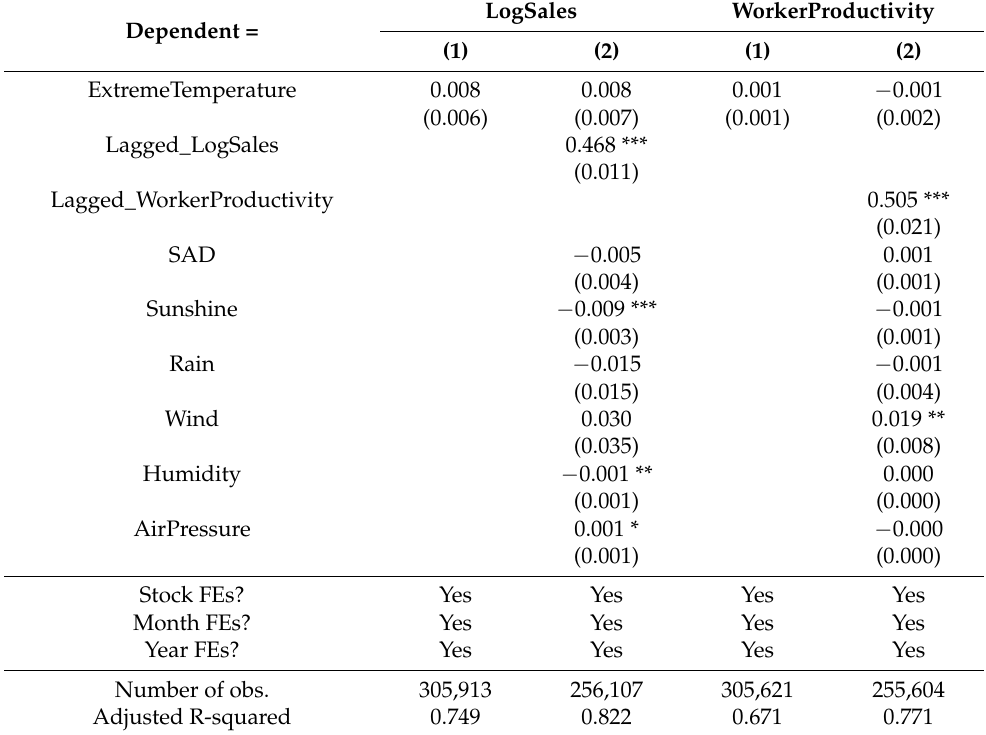
Table 8. The impact of extreme temperature on firm’s productivity.